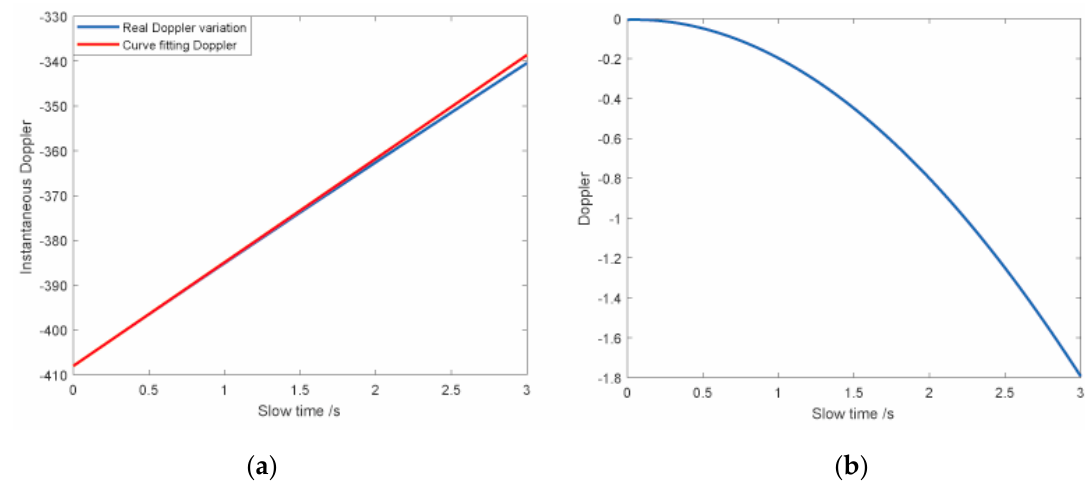
Figure 13. RD map based on MFRT.